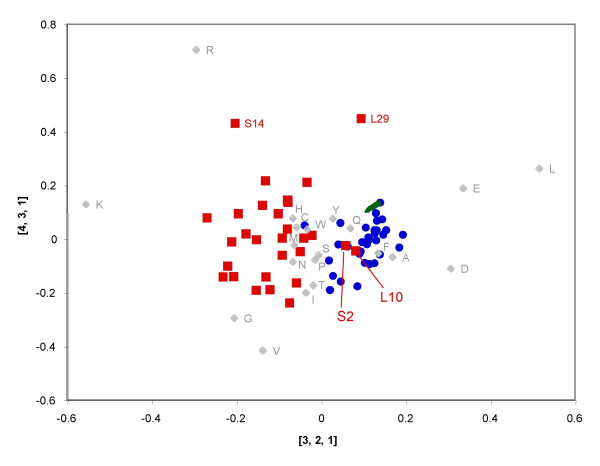
Triplot of [3, 2, 1] and [4, 3, 1] factors. Superimposed plot of the [3, 2, 1] and [4, 3, 1] factors showing the amino acid usage variability related to protein function. The red squares and blue circles represent ribosomal and non-ribosomal proteins, respectively. The green triangles represent the loadings matrix of the organisms.